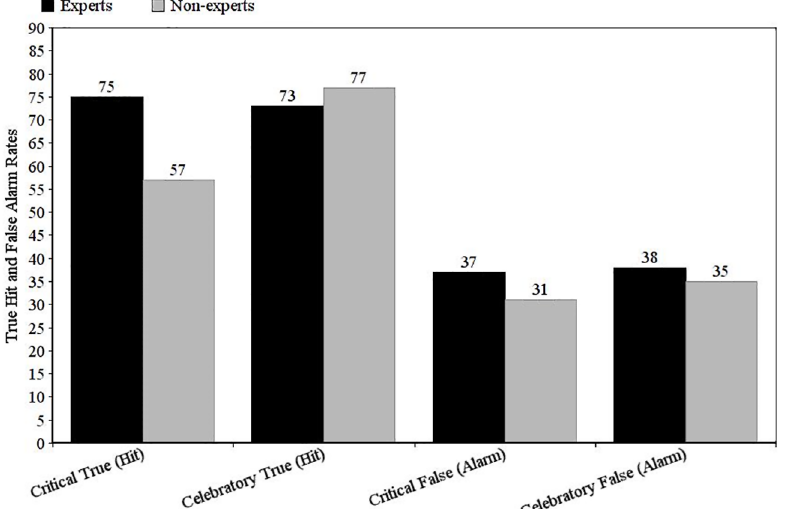
Figure 1. Differences in celebratory and critical